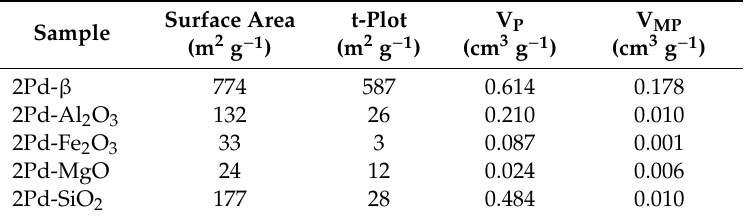
Table 1. Textural properties of Pd-based catalysts (Pd content: 2 wt.%).